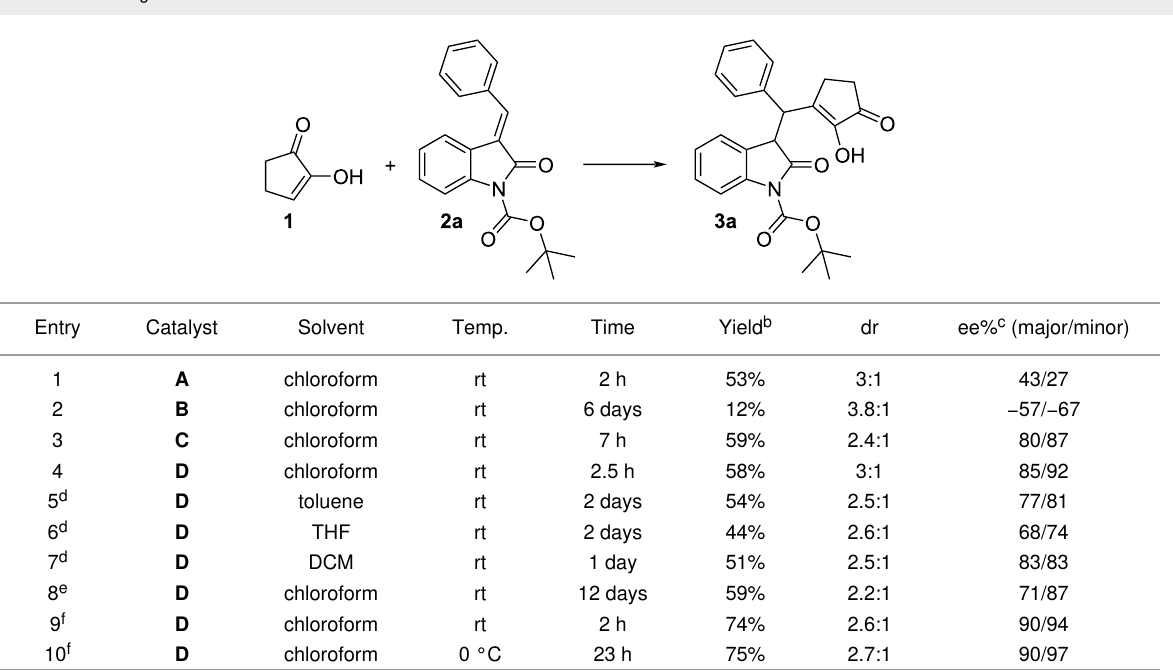
Table 1: Screening conditions for the reaction a